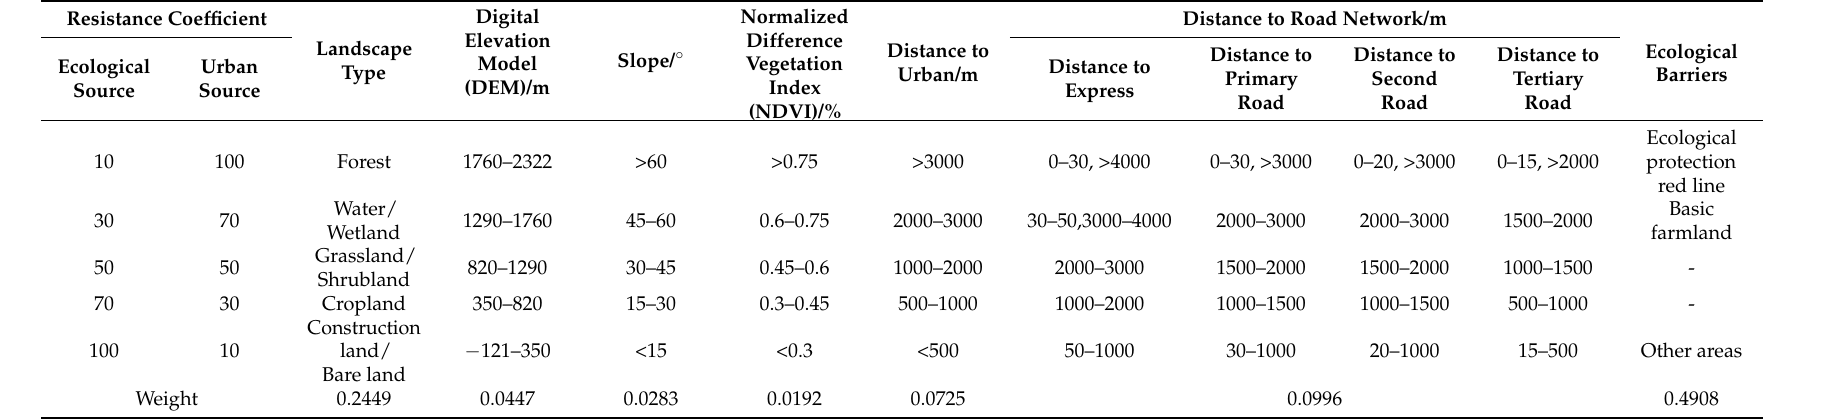
Table 1. Evaluation factor system and resistance value of